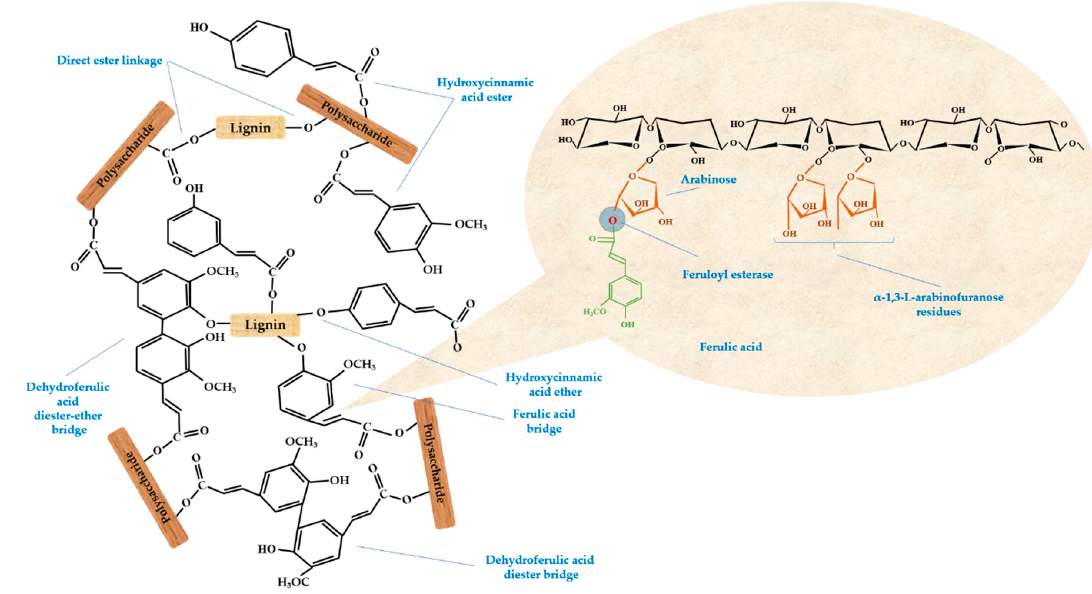
Figure 5. Reported linkages between dietary fiber components and phenolic acids with a loop on ferulic acid structure esterified to arabinoxylan and possible microorganisms-produced enzymes for increased bioavailability.